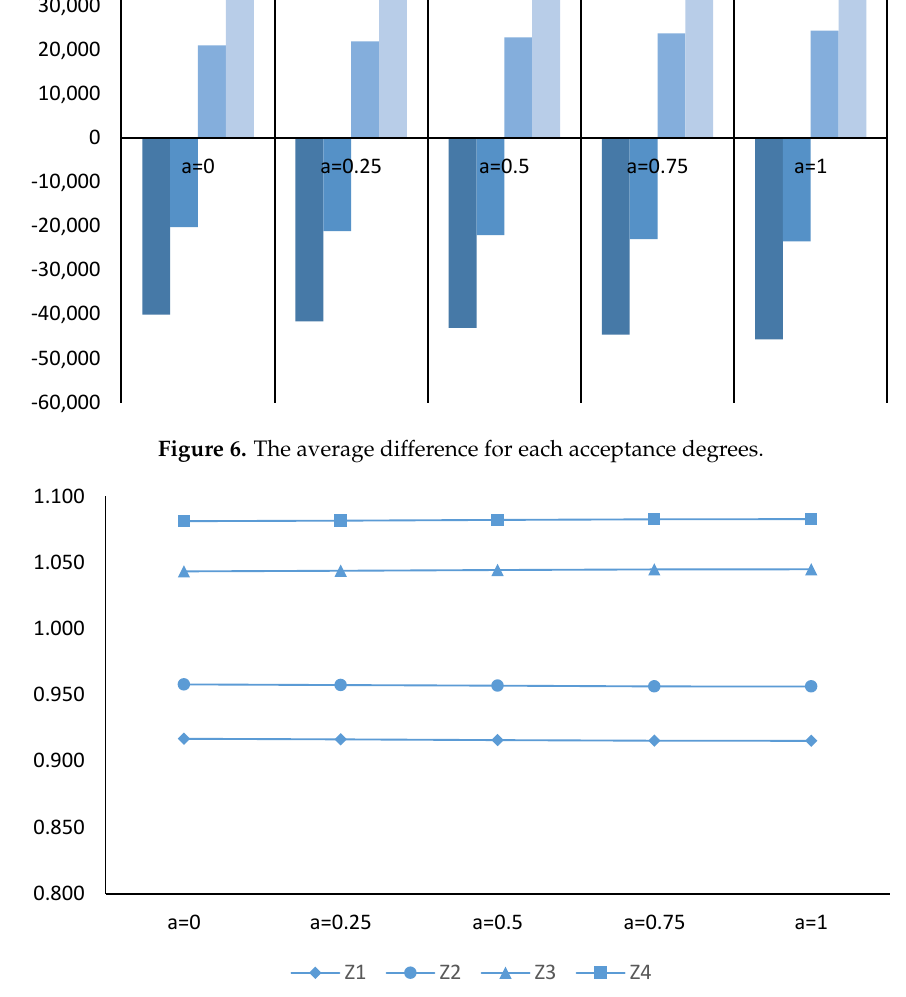
Figure 7. The uncertain degree of benefit results.